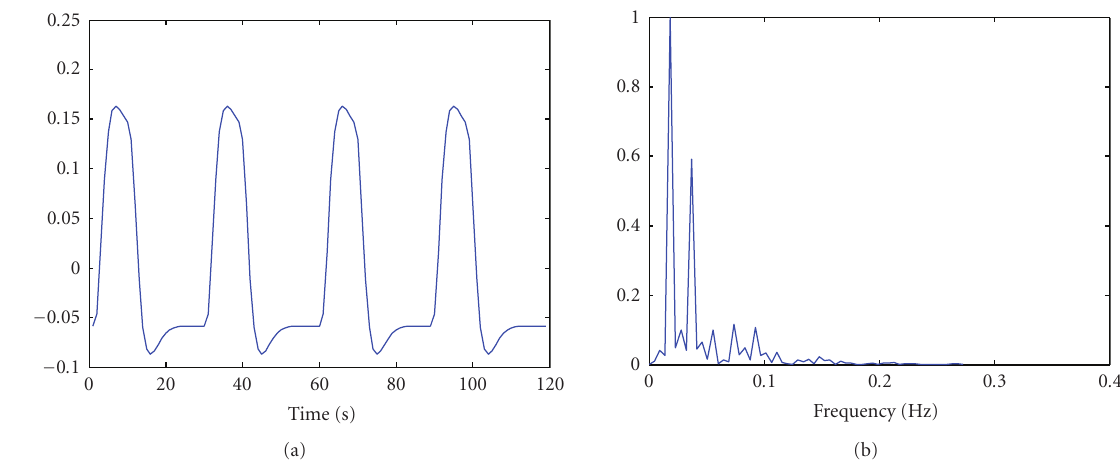
Figure 5: The temporal waveform and frequency spectrum of the predicted right visuomotor time course: (a) temporal waveform, (b) frequency